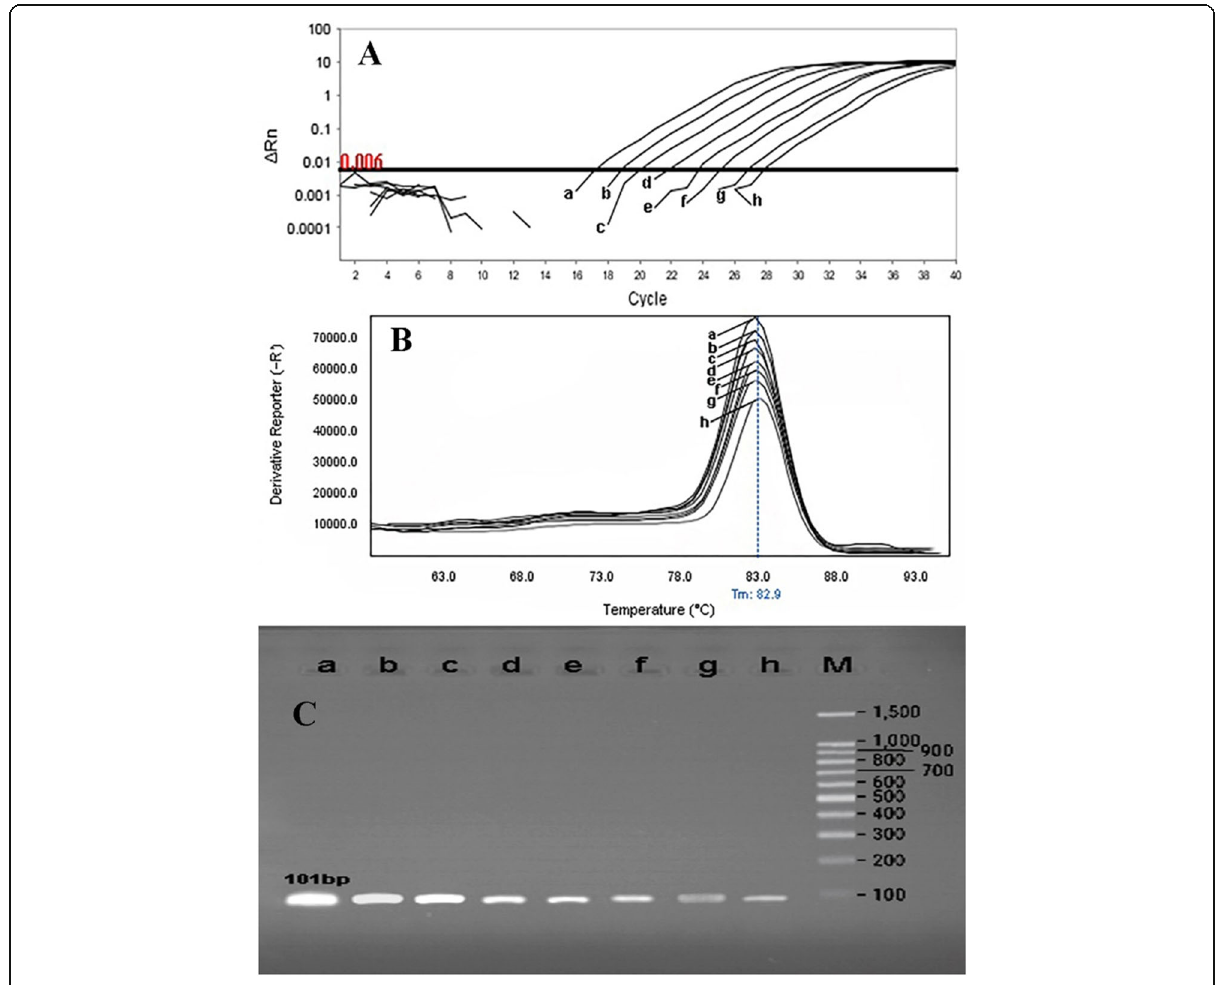
Fig. 3 Sensitivity of real-time PCR for primers used to detect of VRE strains ( vanA gene) with a melting point of 82.99 ± 0.5 °C and amplification curve. E. faecium ATCC51559 (as standard bacteria) with the concentration of 0.5 McFarland (1.5 × 10 8 CFU/ml) was provided into serial dilutions of 10 7 to 10 0 CFU/ml. a 10 7 , b 10 6 , c 10 5 , d 10 4 , e 10 3 , f 10 2 , g 10 1 , and h 10 0 . a Amplification curve, b Melting curve profile, and c corresponding agarose gel (1.5%) electrophoresis for real-time PCR amplification of vanA gene. Horizontal lines represent cycle threshold of real-time PCR. One peak with a shoulder corresponds to genomic DNA amplification; no peak corresponds to no amplification. SYBR Green I color and